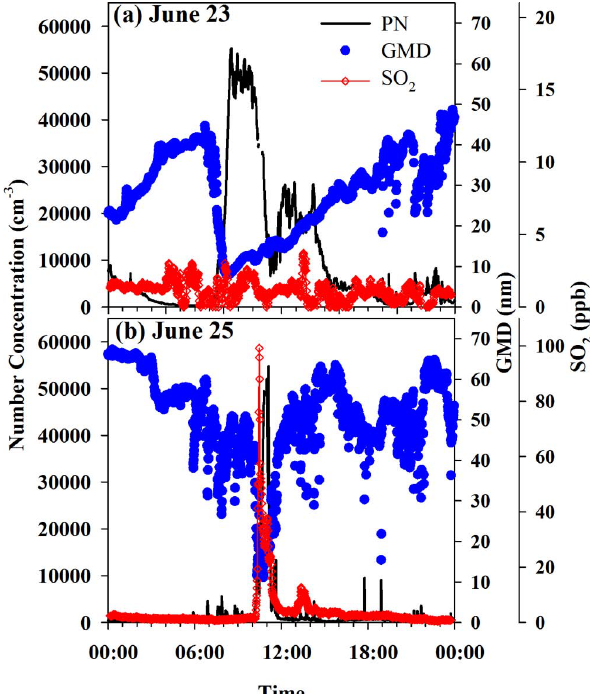
Fig. 6. Examples of the variations in the number concentration of particles (PN, < 25nm) and geometric mean diameter for par- ticles smaller than 100nm during particle nucleation and growth events measured at Harrow on 23 June – Class I, (a) and 25 June – Class II, (b) ,